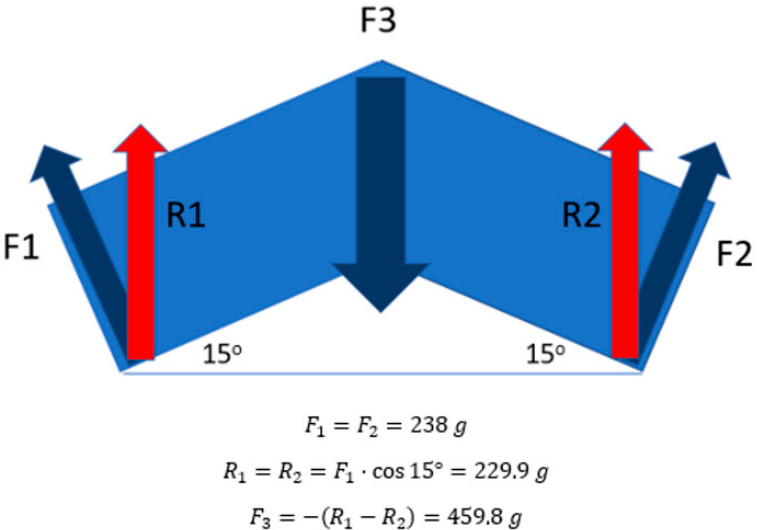
Figure 10. PIPJ dorsal force applied formula. When ETDNO is applied, it only covered the whole length of the second phalanx and 2/3 of the length of the lever arm of the first phalanx. We considered the distal and proximal lever arm of the PIPJ to be the same length. For this reason, we consider the distal and proximal forces applied to be of equal amounts. F1 and F2 were the forces that the ETDNO apply, while R1 and R2 was the results of the forces when considering the angle of the force. F3 was the force applied at the dorsal aspect of the